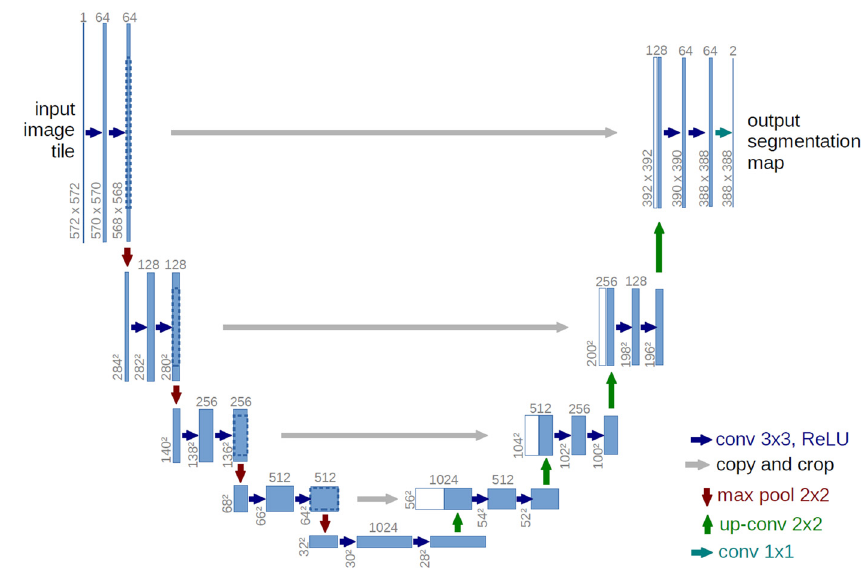
Figure 6: Architecture for the 2D U -